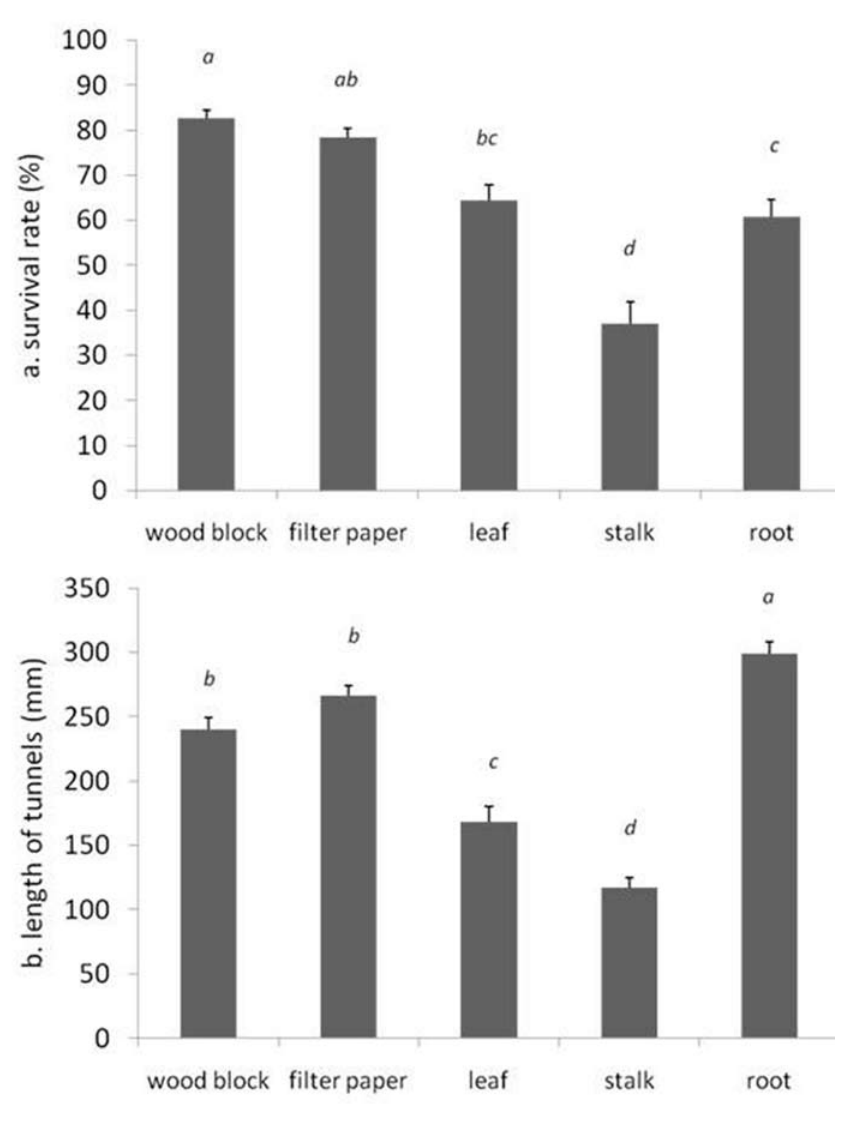
Fig.1 (A) Mean survival rate ND (B) mean tunnel length of Coptotermes formosanus on diferemnt food sources across Bt and nd non-Bt maize hybrids. Mean v alues followed by the same letter are notsignkficantly different